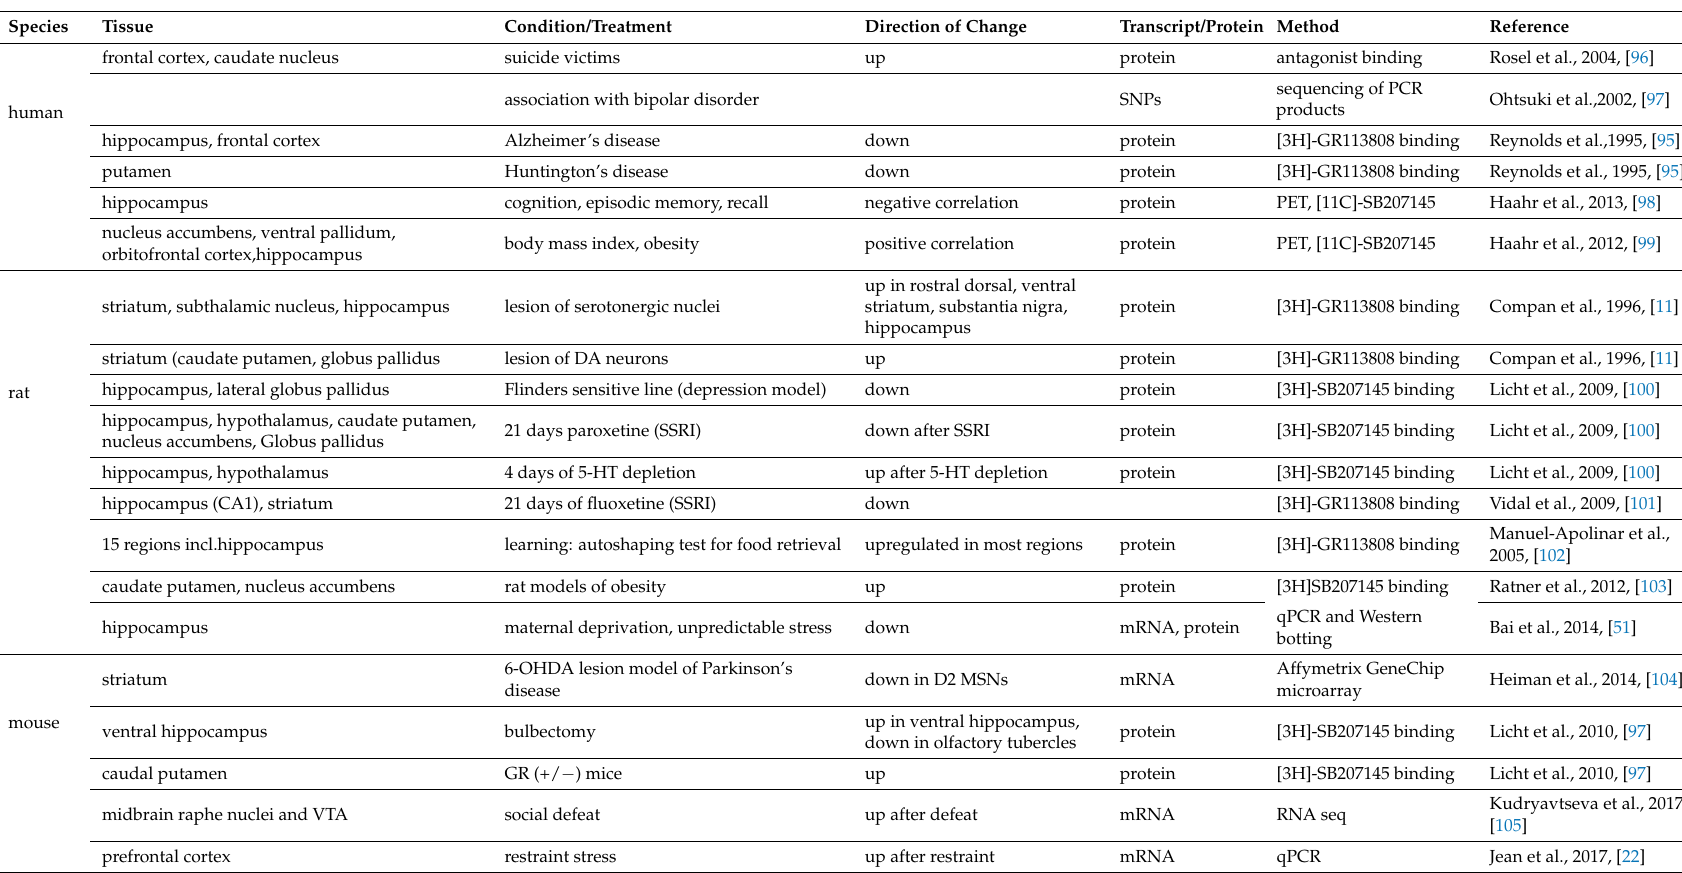
Table 2. Compilation of studies of expression of the 5-HT4 receptor in human, mouse and rat brain in the disease state, in disease models or after drug treatment.